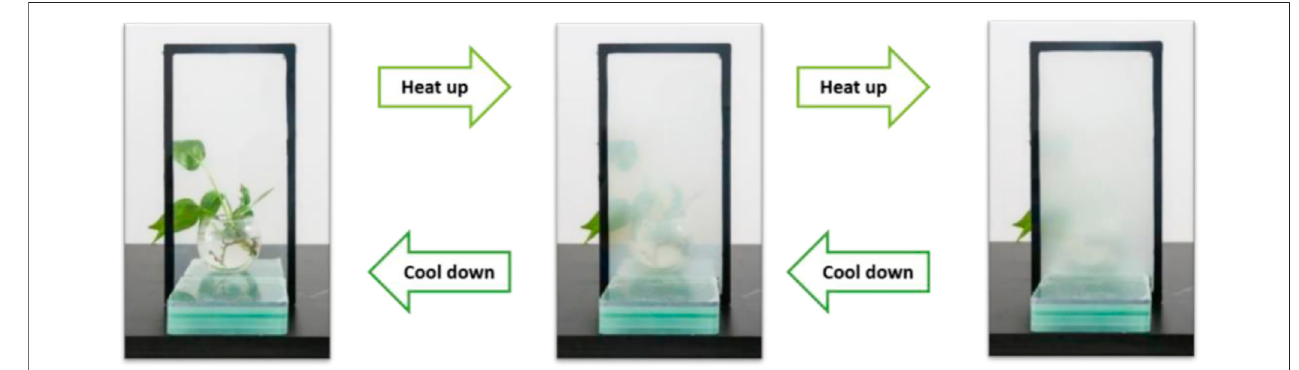
FIGURE 1 | Atomization process of thermochromic glass at change temperature 35 °